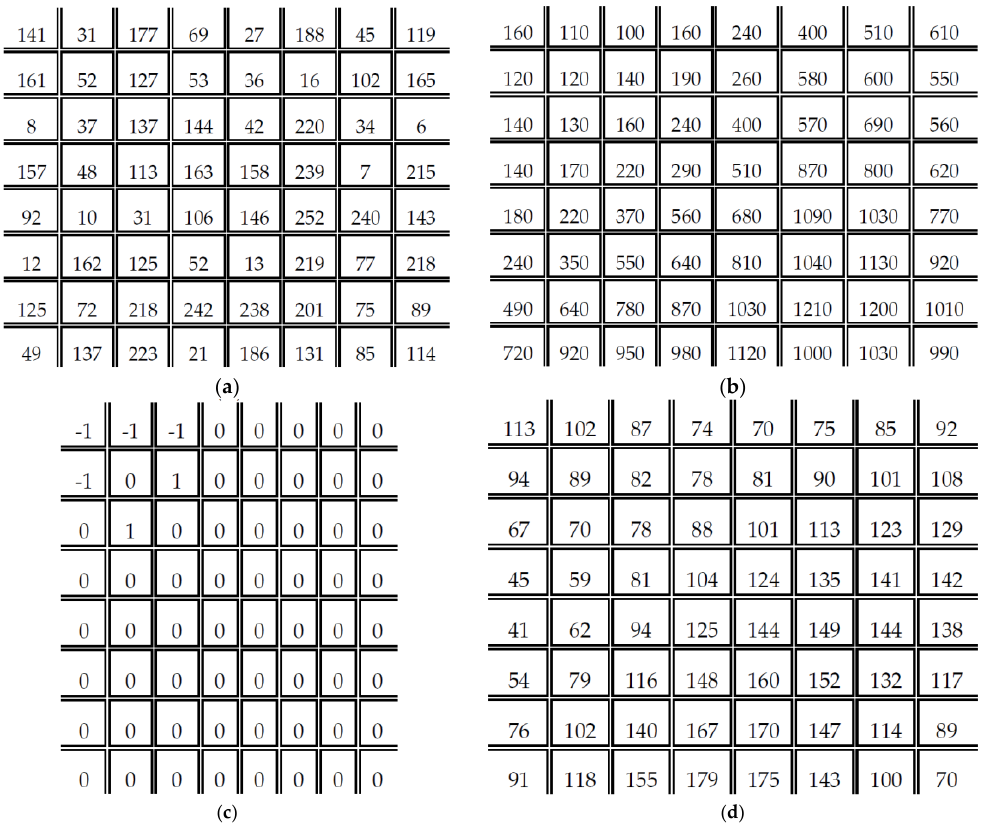
Figure 1. Example of JPEG compression with 𝑄 = 5 : ( a ) input image block 𝑏(𝑖,𝑗) ; ( b ) quantization matrix ℚ ; ( c ) encoded image 𝐵̃(𝑥,𝑦) ; and ( d ) decoded image.